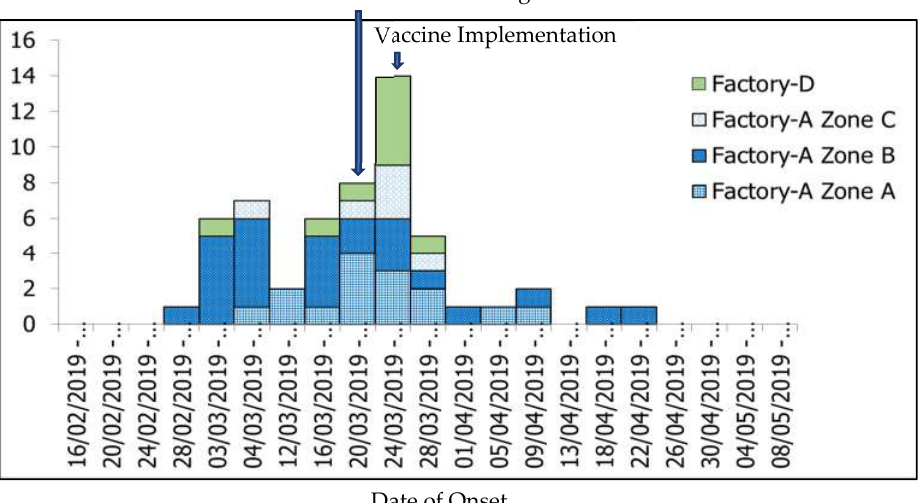
Figure 1. Epidemic curve of measles outbreak in Factory-S and Factory-D from 14 February to 28 March 2019 ( N = 56).